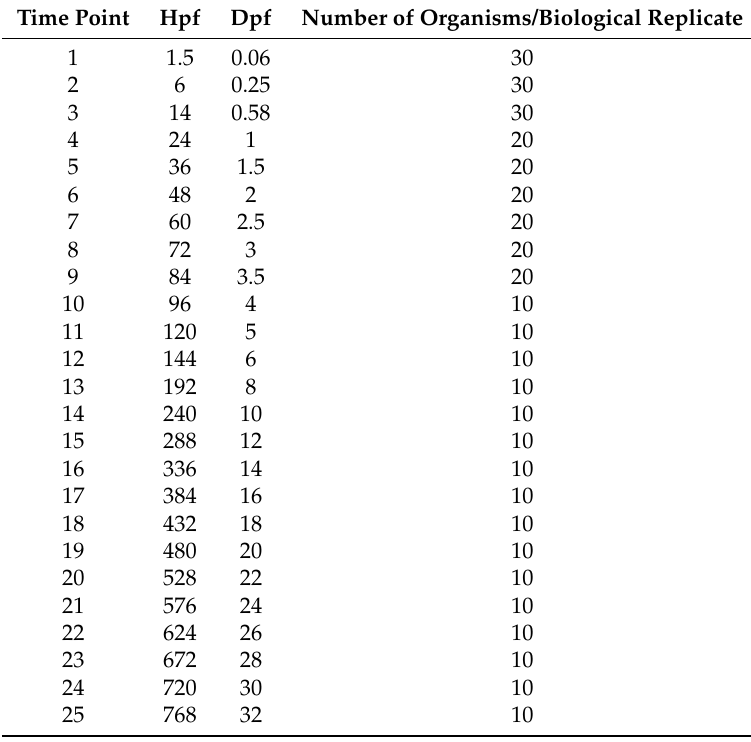
Table 2. Overview of sampling time points for analysis of mRNA